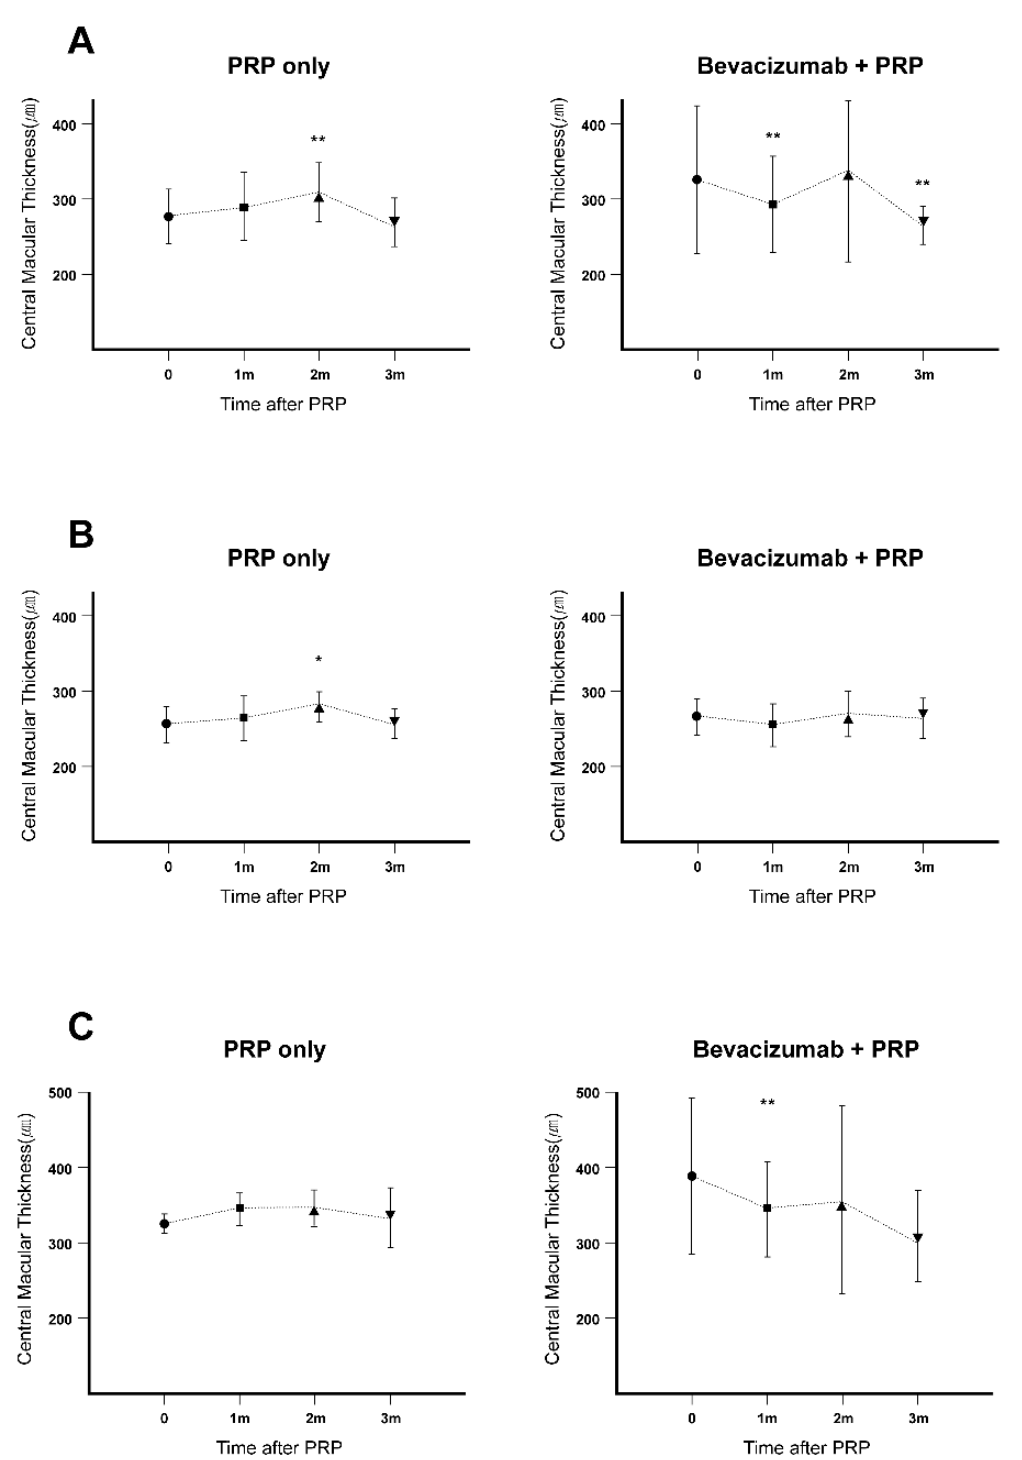
Figure 2. Changes in CMT in patients with PDR who received PRP with or without preoperative IVB injection. The mean CMT was measured using central thickness mapping with OCT at baseline and one, two, and three months after PRP (* p < 0.05, ** p < 0.01). ( A ) Overall changes in CMT in the two groups. ( B ) Changes in CMT in patients without baseline ME in both groups. ( C ) Changes in CMT in patients with baseline ME in both groups. IVB: intravitreal bevacizumab, PRP: panretinal laser photocoagulation, PDR: proliferative diabetic retinopathy, CMT: central macular thickness, OCT: optical coherence tomography, ME: macular